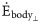
Mechanical power against normalized cycle time at shallow (INC5, 5%) and steep (INC12, 12%) inclines in uphill DP.Top, middle, and bottom panels represent low, moderate, and high external power, respectively. Lines represent mean with 95% CI indicated by shaded area [N = 14]. Pole power (Ppole), total muscle power output (Ptot), arm power (Parm), and trunk+legs power (PT+L). Also shown is the rate of change of mechanical energy associated with body movements perpendicular to the treadmill belt (E˙body⊥). The vertical dashed lines represent end of poling phase.